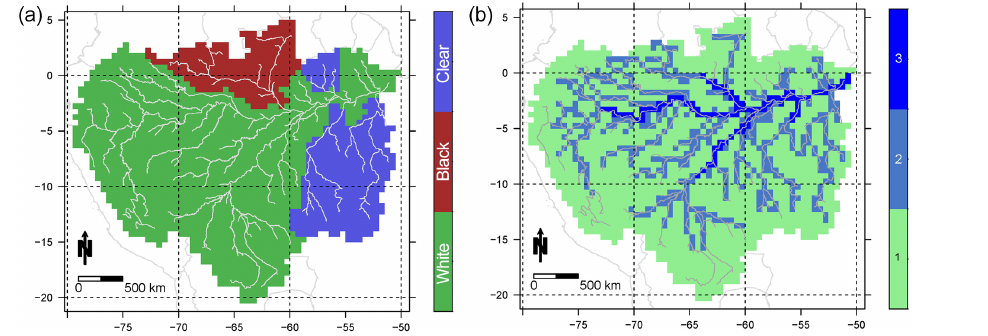
Figure 3. River type (a) and river order (b) . Cells of river order 1 (headwater) have a mean annual discharge of less than 8 × 10 3 m 3 yr − 1 ; cells of river order 2 have a discharge between 8 × 10 3 and 2 × 10 5 m 3 yr − 1 ; cells of river order 3 have a discharge higher than 2 × 10 5 m 3 yr − 1